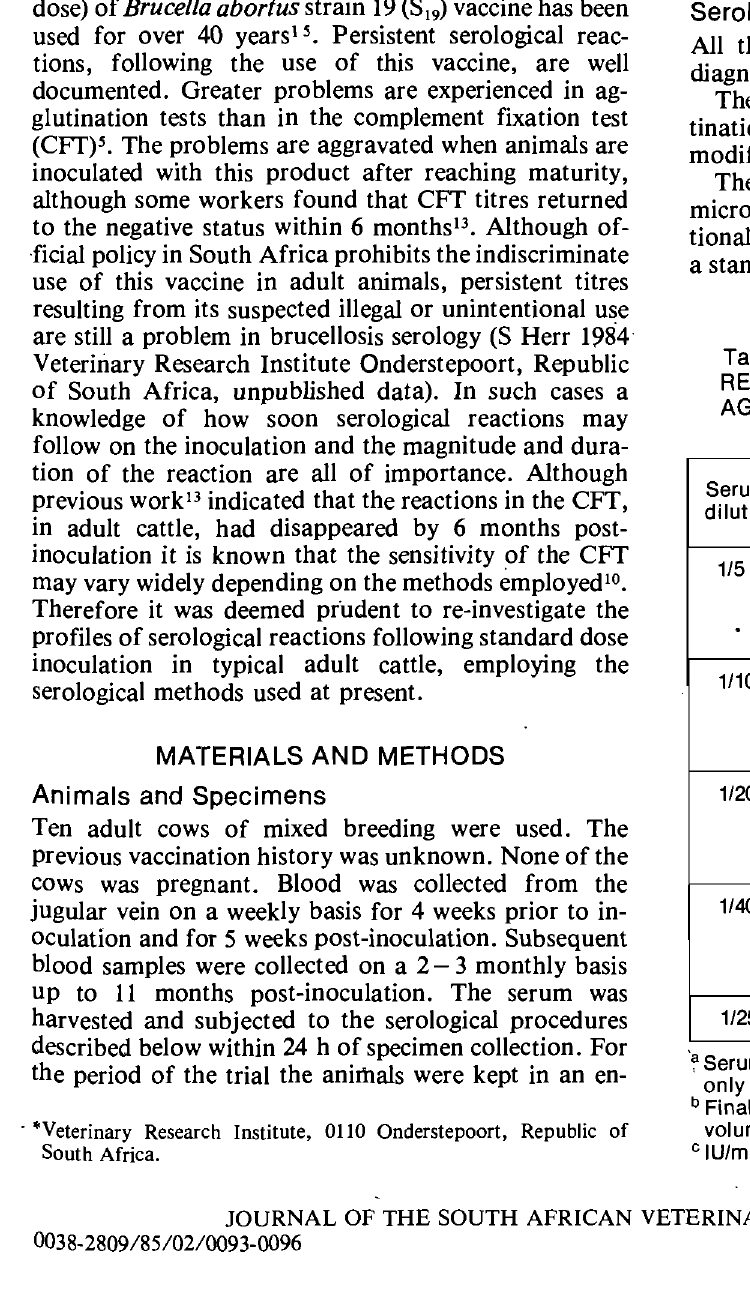
Table 1: THE CONVERSION OF SAT END-POINT REACTIONS TO IU/ml ON A SCALE WHERE